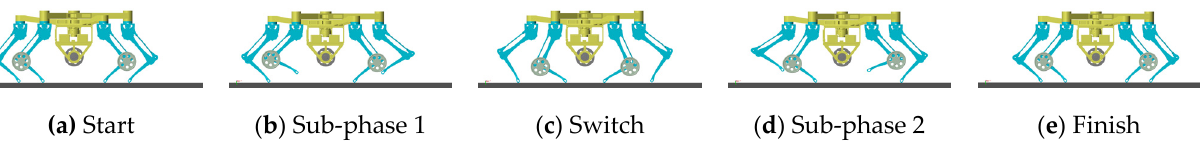
Figure 9. Simulation of tripod gait motion using TeCVP.